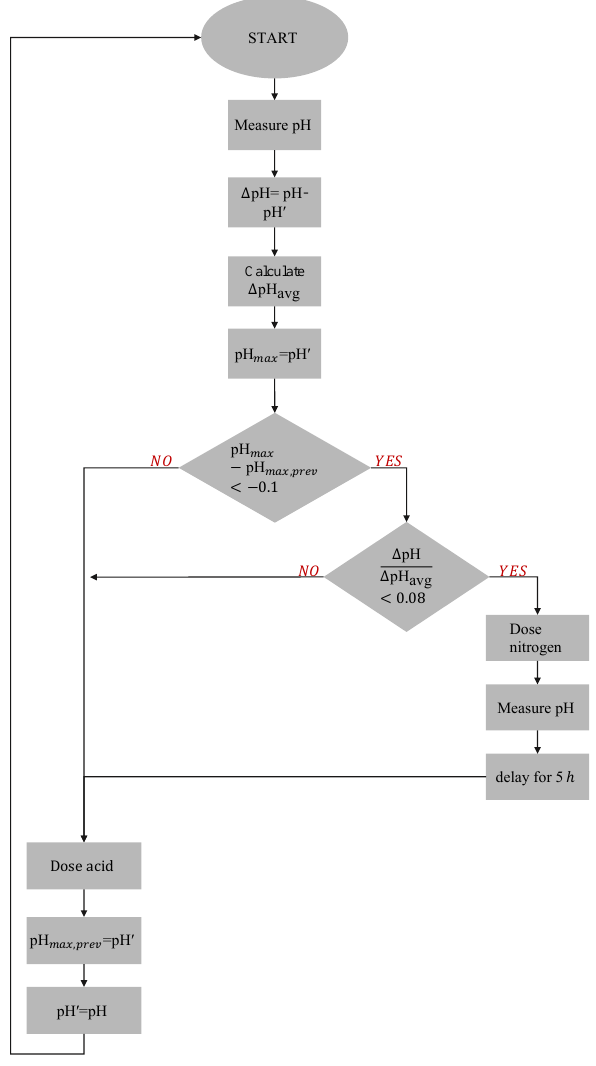
Figure 4. Control algorithm for detection of low nitrogen concentration. The pH was controlled by acid dosing according to a standard proportional-integral control algorithm. pH measurements were taken every 30 min (sampling time) and acid dosing occurred every 60 min (amounts dictated by the control algorithm). The slope between the pH measurement 30 min after an acid dosing instance and the pH immediately before to next acid dosing instance was recorded. A reduction in this slope indicates a reduction in the hydroxide exudation (nitrate uptake) of the duckweed. The ratio between this slope ( ∆ pH ) and the running average of these slopes (ten previous values) ( ∆ pH avg ) was used as an indication of nitrate extinction. If this ratio ( ∆ pH/ ∆ pH avg ) fell below a threshold of 0.08 ( (cid:101) ), the nitrogen was too low and assumed to be exhausted. Thereafter a pump was turned on to feed wastewater (containing nitrate) into the tank only after a reduction in the pH maxima ( pH max ) slopes greater than 10% over